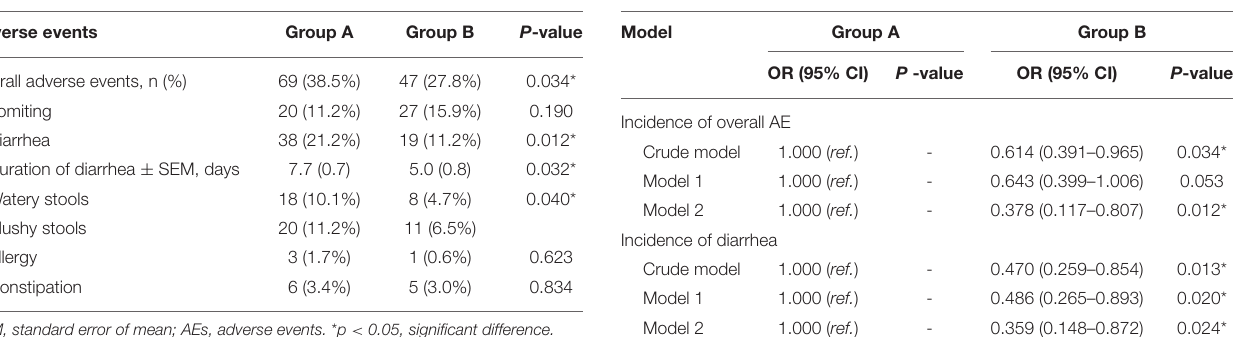
TABLE 4 | Comparison of incidence of AEs among two